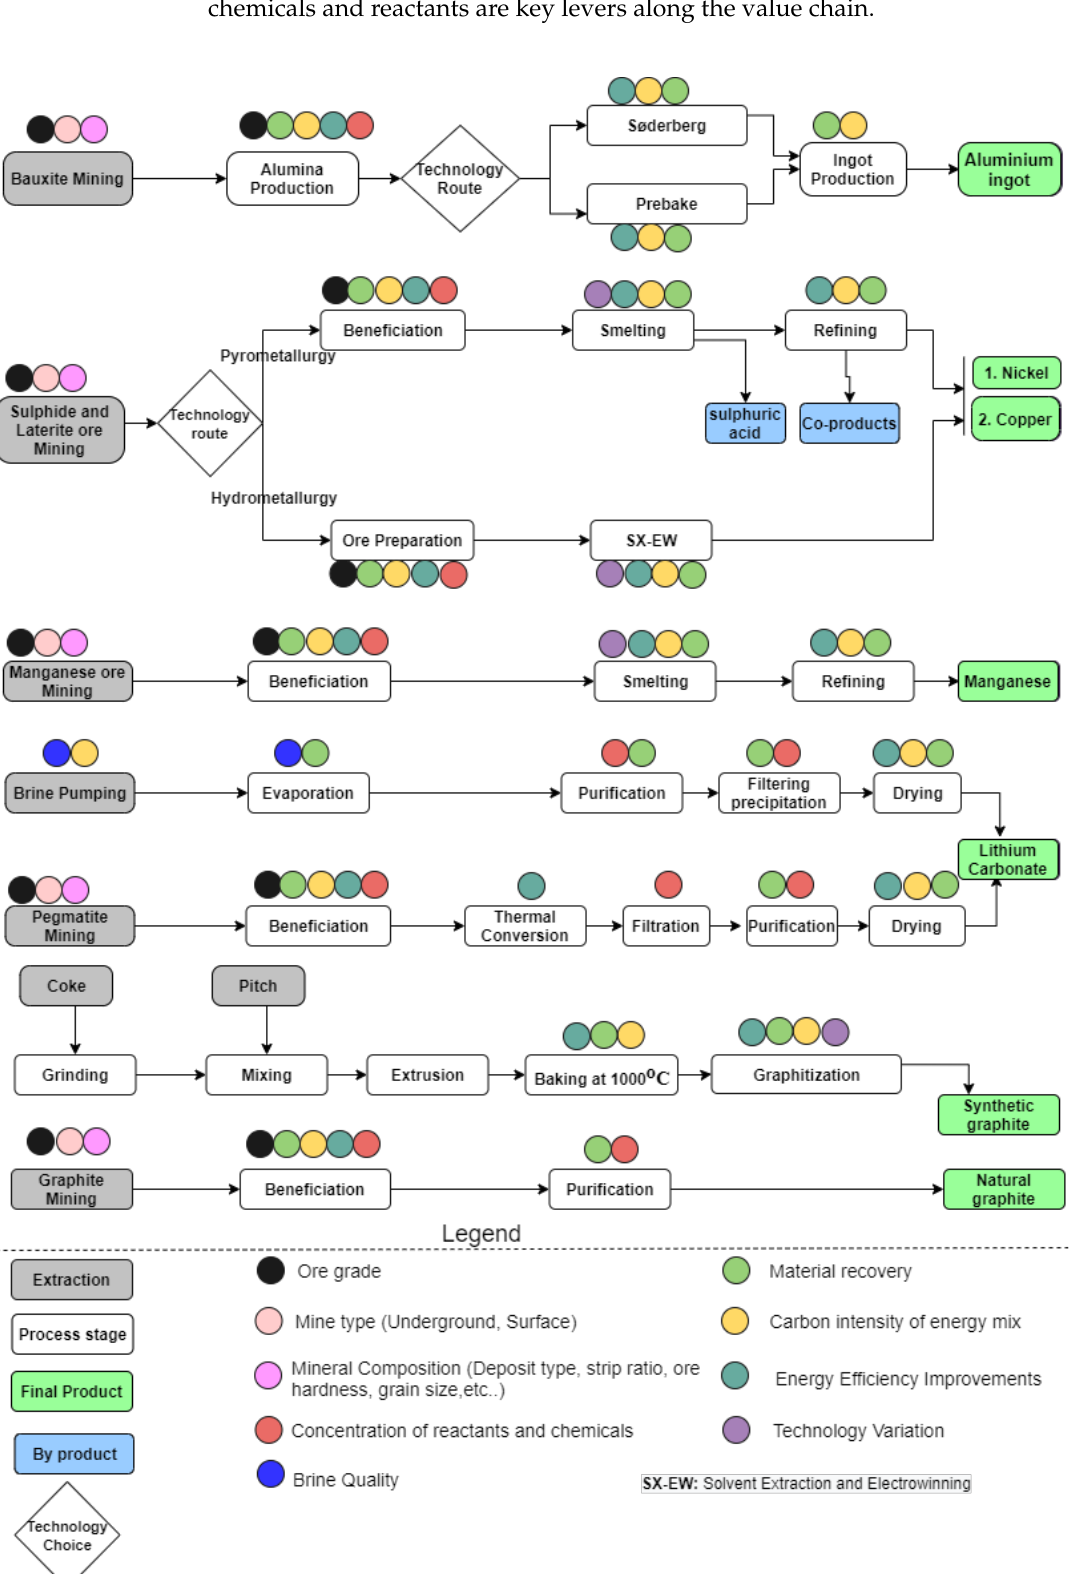
Figure 1. Value chain description with levers.